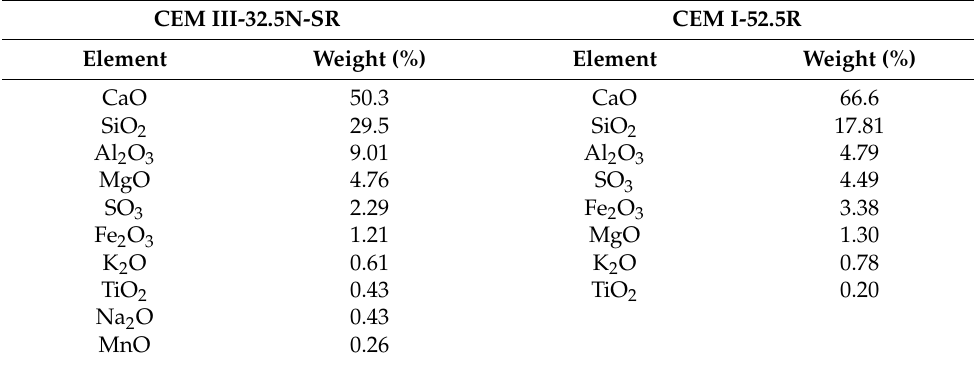
Table 3. Chemical composition of the different cements.